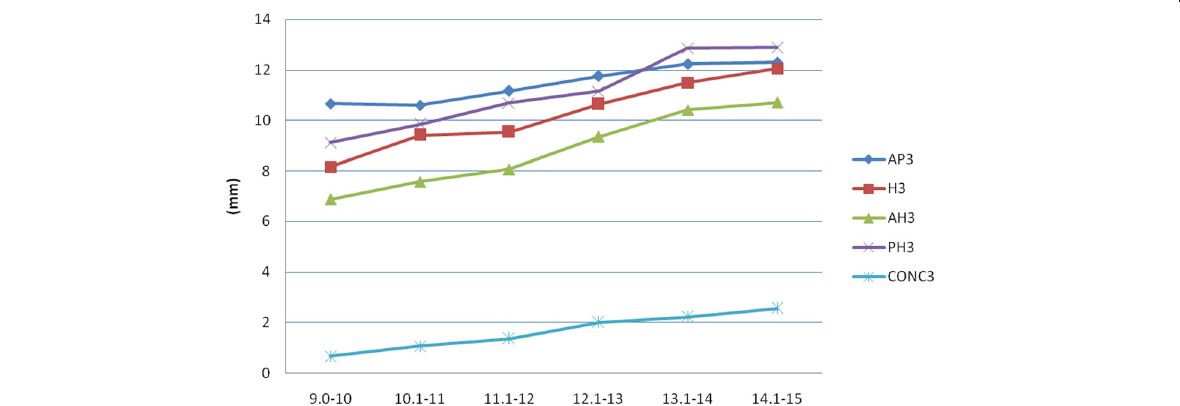
Fig. 2 Changes in the parameters of C3 in females (AH, anterior height; PH, posterior height; H, middle height; AP, anteroposterior length; CONC, depth of concavity)